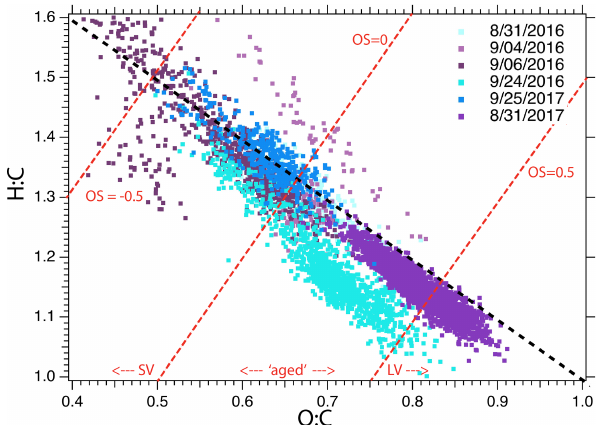
Figure 8. Hydrogen-to-carbon (H : C) molar ratio versus oxygen- to-carbon (O : C) molar ratio, colored by flight date, shown at the native 5s time resolution. Superimposed are lines of constant oxi- dation state (OS, defined as 2 · O : C − H : C; Kroll et al., 2011), used to define semi-volatile (SV), aged, and low-volatility (LV) oxidized organic aerosol (OOA)